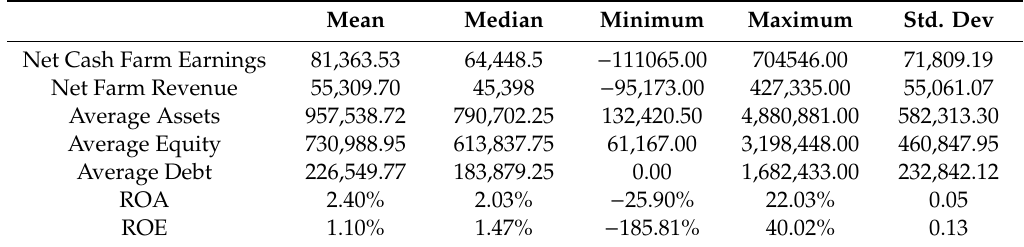
Table A3. Vermont Organic Dairy Financial Performance (USD) 2006–2016 (n =